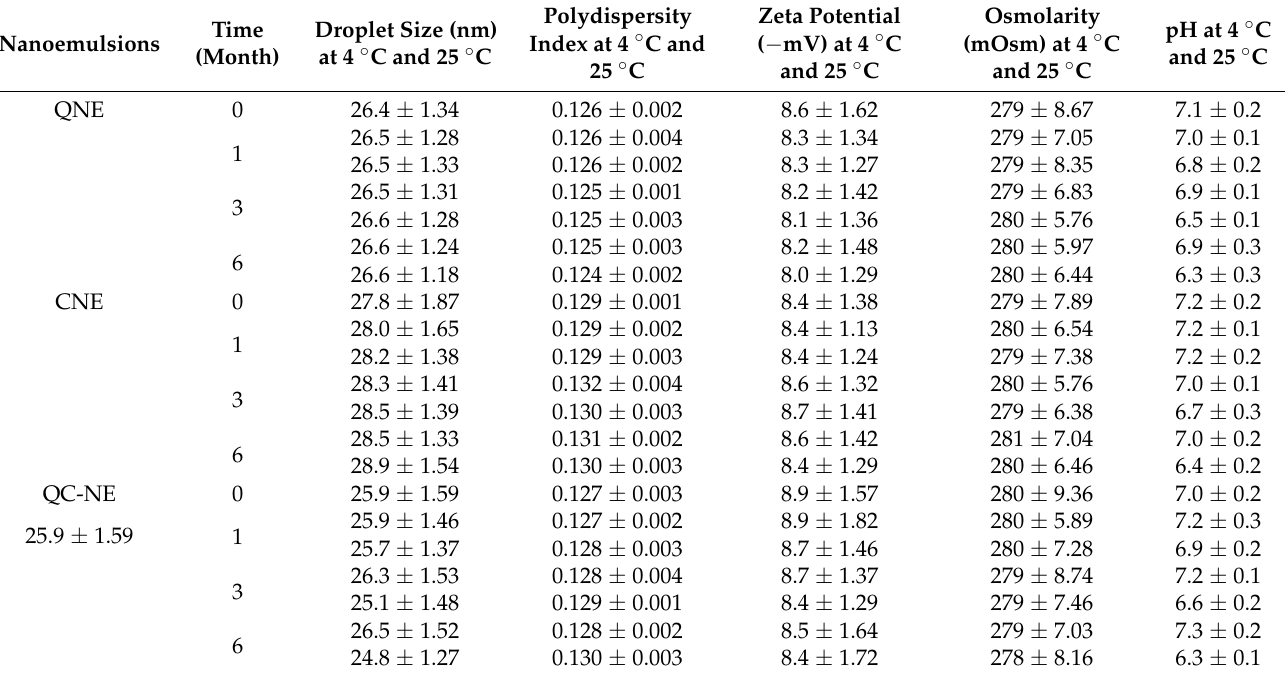
Table 3. Effect of storage condition and time on droplet size, polydispersity index, zeta potential, osmolarity and pH